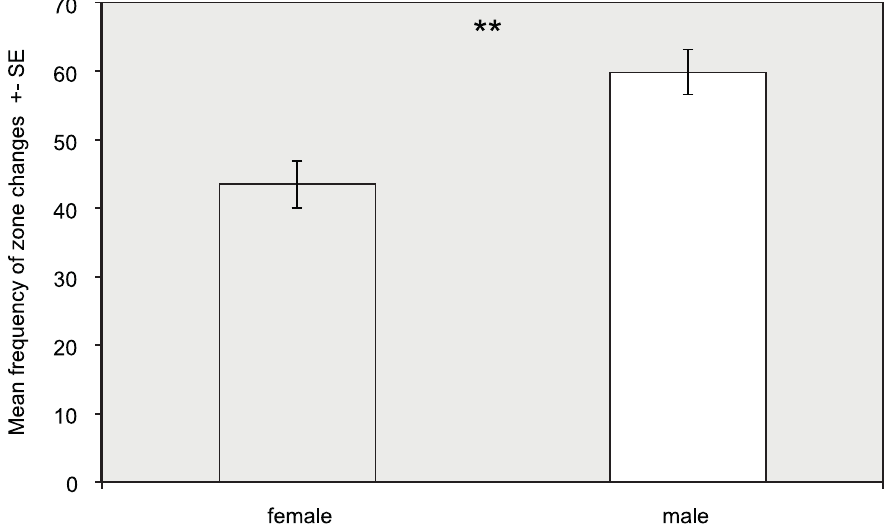
Figure 5. Sex differences in mean activity: males are significantly more active than females.